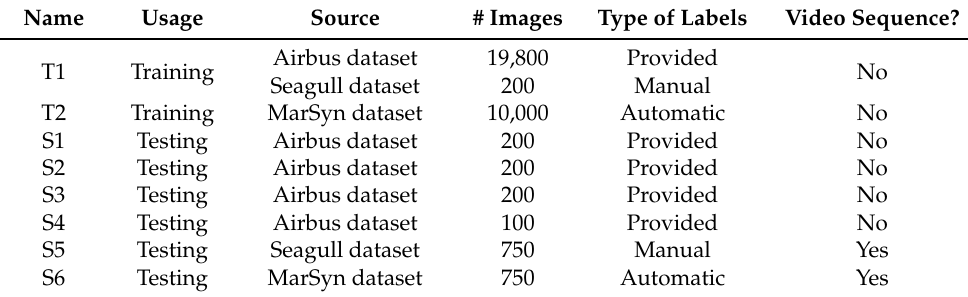
Table 2. Different datasets used in this work.